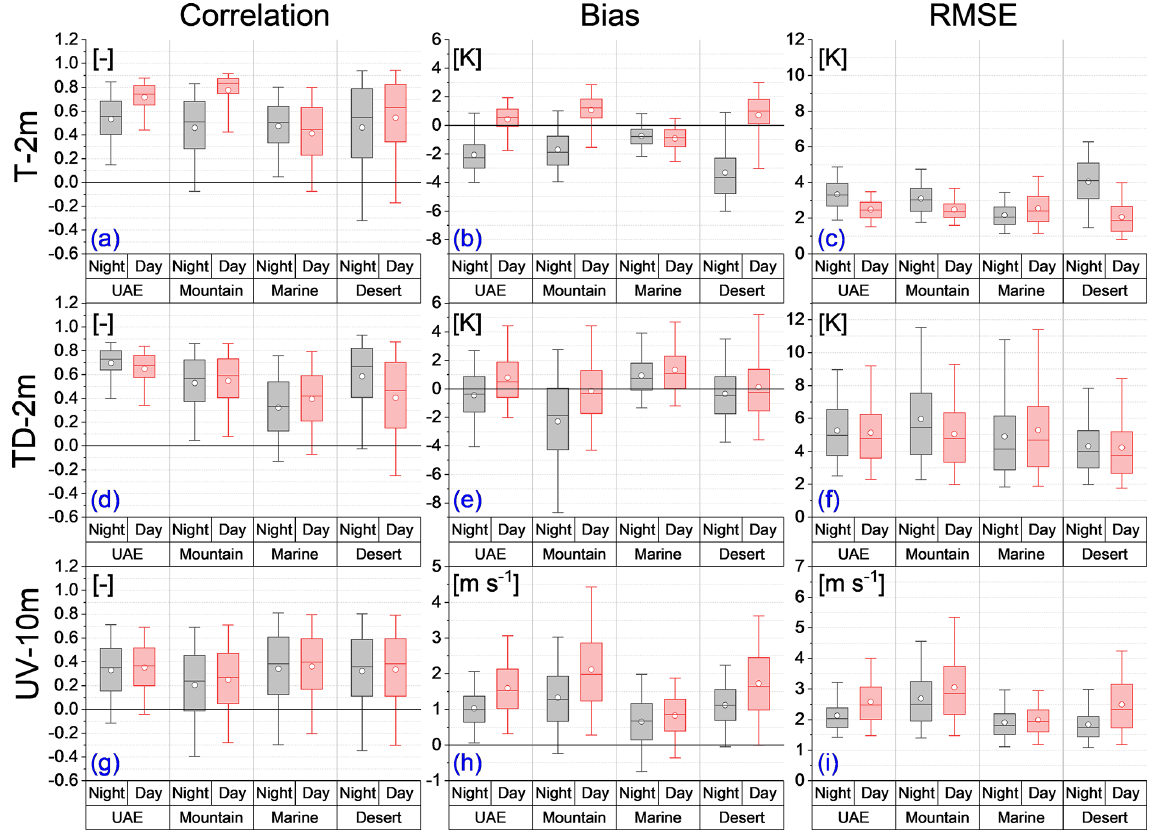
Figure 7. Box plots of T 2m , TD 2m , and UV 10m (respectively, panels a–c , d–f , and g–i ) for all time steps over the period of January– November 2015. Statistics are divided by region (UAE, mountain, marine, desert) and then by nighttime and daytime hours (respectively, night 18:00–05:00 (grey boxes) and day 06:00–17:00 (red boxes) in local time). Statistics shown are Pearson correlation (a, d, g) , bias (b, e, h) , and RMSE (c, f, i) . On the box plots the center line represents the mean, the white circle is the median, box ends represent 25% and 75% percentiles, and the whiskers are 5% and 95% percentiles. Also marked is a horizontal zero reference line for the Pearson and bias statistics. Table 4. The 2015 Oceanic Niño Index (ONI) (3-month running mean of ERSST.v5 SST anomalies in the Niño 3.4 region at 50 ◦ N–50 ◦